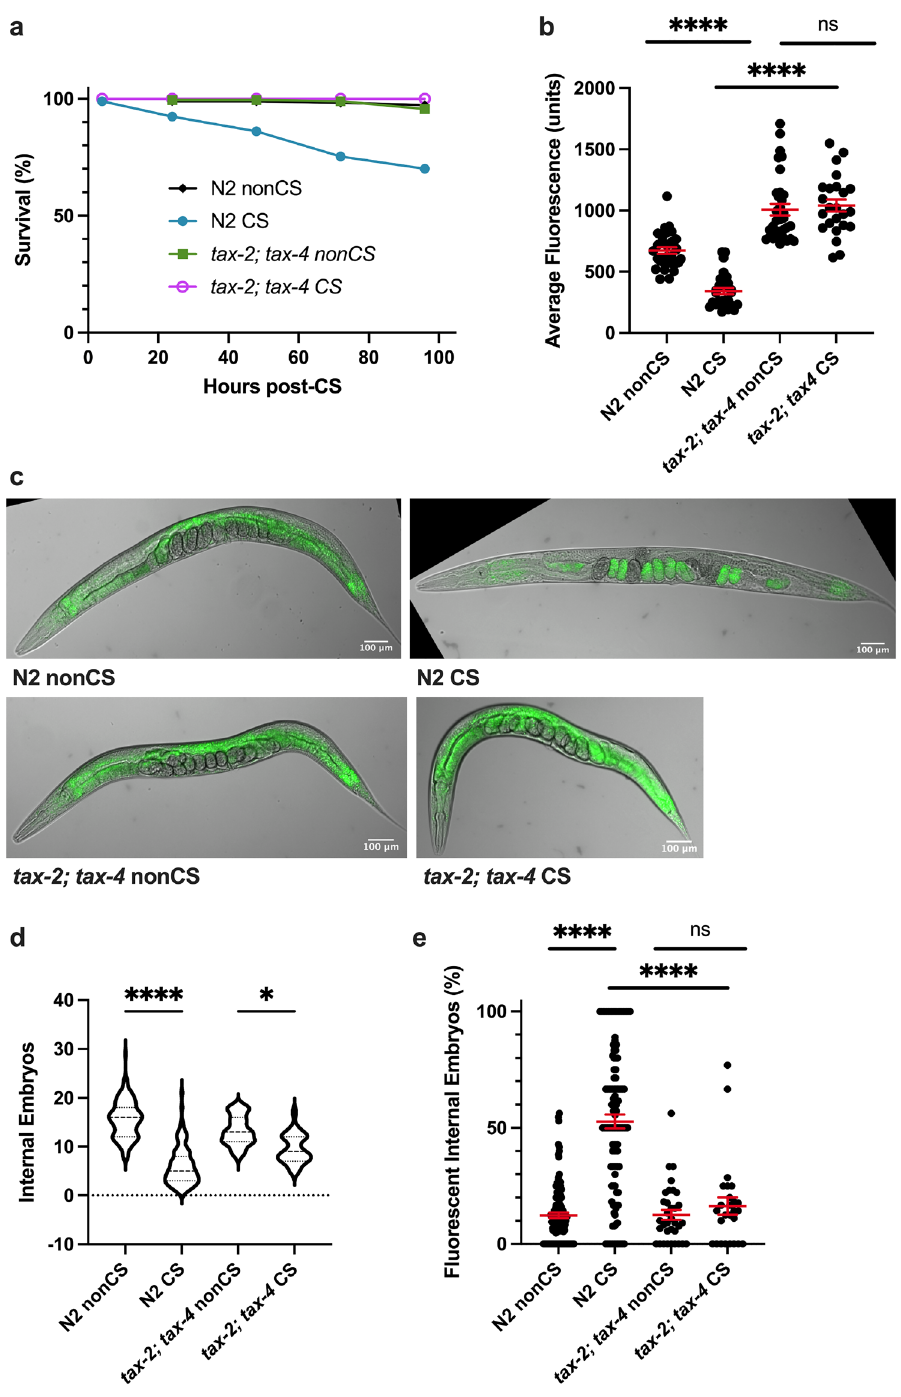
Figure 3. TAX-2; TAX-4-mediated thermosensation is required for lipid relocalization following cold shock. ( a ) tax-2(p671); tax-4(p678) double loss-of-function mutants were cold shocked and recovered while monitoring survival rates (n ≥ 120 worms per condition). ( b ) At 12 h post-CS or nonCS control, tax-2(p671); tax-4(p678) were Nile Red lipid-stained and the average fluorescence per worm was quantified (Kruskal–Wallis test: H = 83.83, P < 0.0001; Dunn’s Multiple Comparison test: **** P < 0.0001). ( c ) Representative images of Nile Red staining show retention of fluorescence in the intestines of tax-2; tax-4 mutants. ( d ) Number of embryos (Kruskal–Wallis test: H = 171.1, P < 0.0001; Dunn’s Multiple Comparison test: * P = 0.0484, **** P < 0.0001) and ( e ) percent fluorescent internal embryos (Kruskal–Wallis test: H = 100.1, P < 0.0001; Dunn’s Multiple Comparison test: **** P < 0.0001) were quantified per worm from Nile Red images (n ≥ 24 worms per condition for b-e; error bars are mean ±